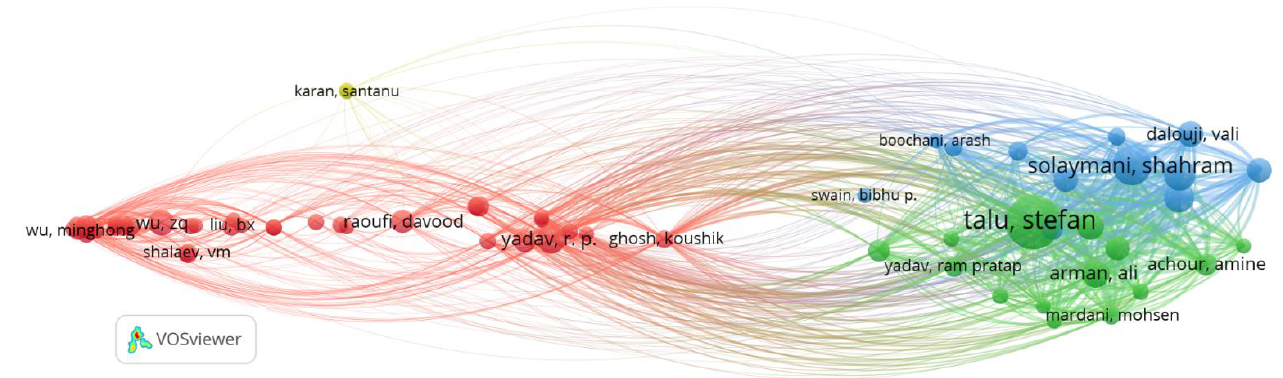
Figure 11. Bibliographic coupling of authors publishing in fractal theory of thin film materials. Minimum number of documents and citations for each author is 5 and 20, respectively.